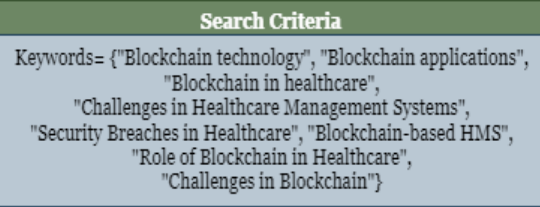
Figure 2 . Possible search keywords used in review .